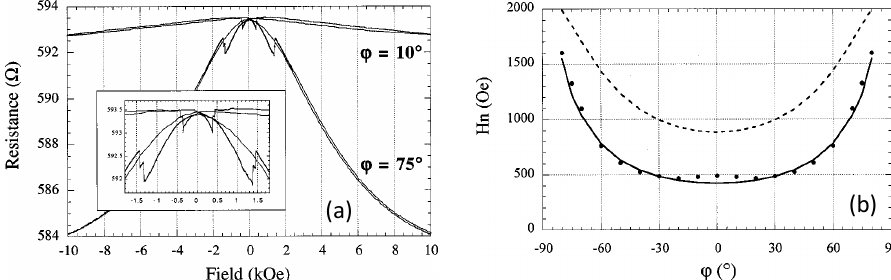
FIG. 4. Nucleation field at 300 K vs # for a single Ni wire ( d " 75nm). Dashed line: expected nucleation field for an infinite cylinder with d